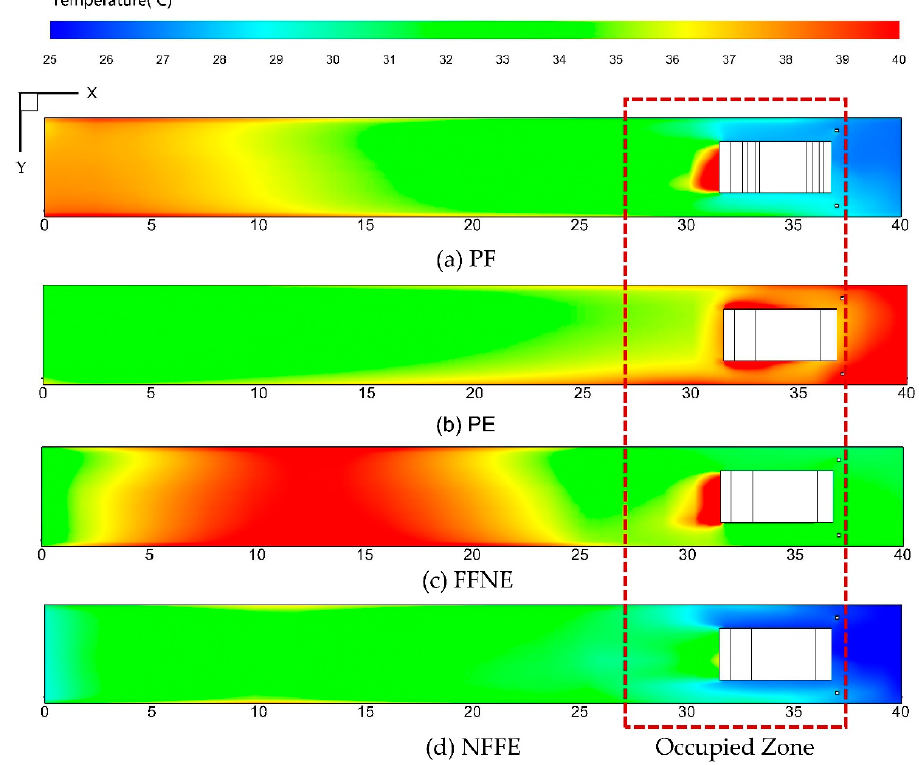
Figure 20. Geometry model of the PF ( a ), PE ( b ), FFNE ( c ), and NFFE ( d ) ventilation systems.